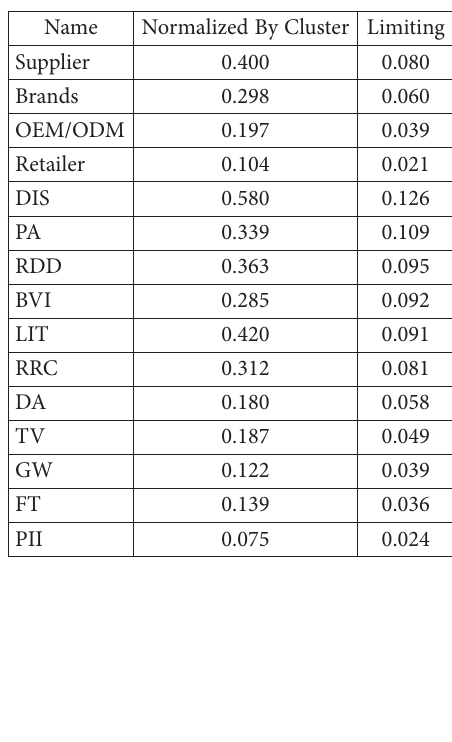
Table 7. The results of the ANP